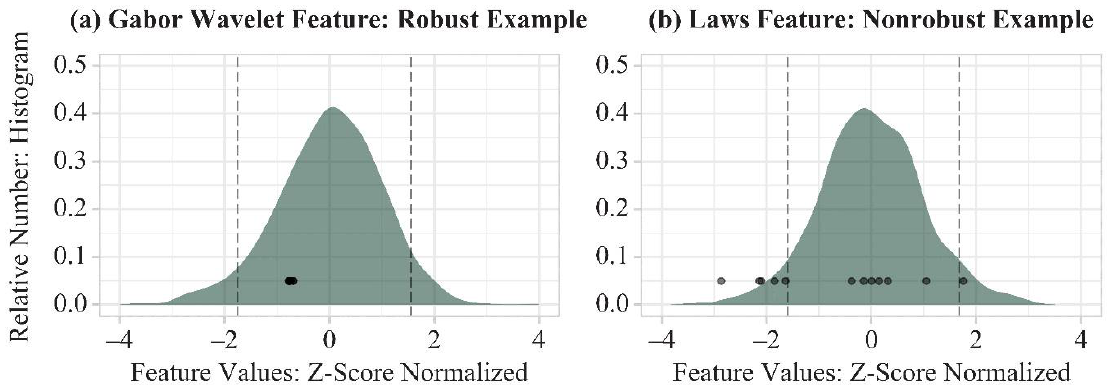
Figure 1. Histograms of the clinical distributions of two radiomic features. Superimposed points show the values obtained from imaging the phantom, with each data point corresponding to an x-ray acquisition (six unique kV/mAs combinations, repeated twice). ( a ) An example of a robust feature. The 12 phantom data points show very little variation relative to the clinical distribution; ( b ) An example of a non-robust feature. The data derived from the phantom span a broader range.